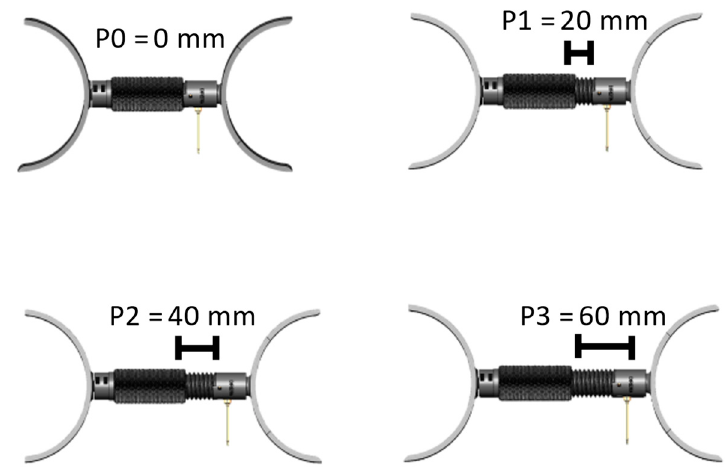
Figure 9. Device positions considered in the tests.